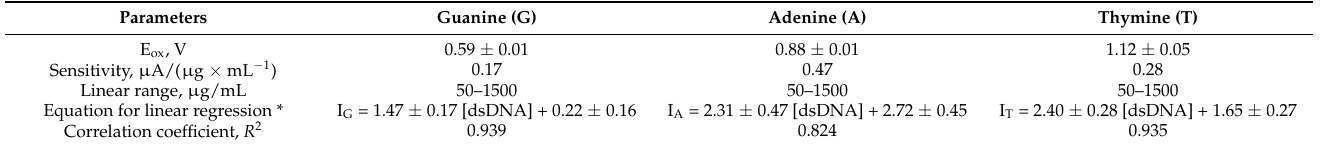
Table 2. Electroanalytical parameters of dsDNA on SPE/SWCNT using DPV technique.